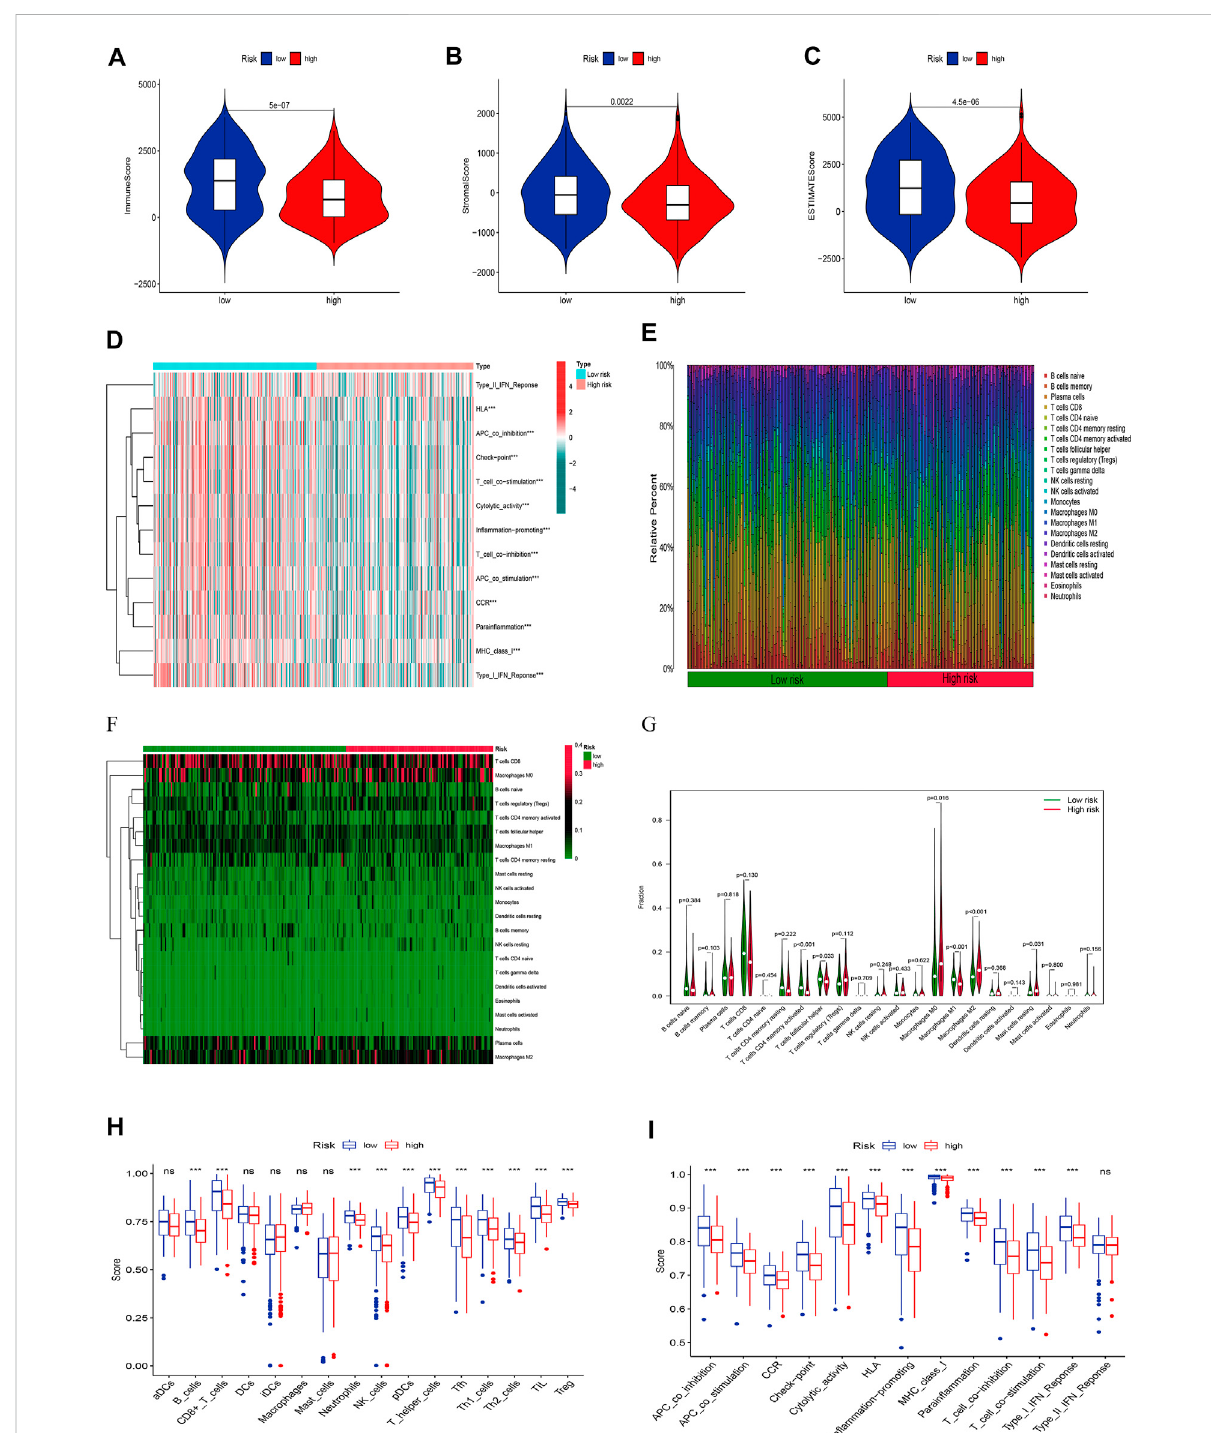
FIGURE 8 Analyses of tumor immune microenvironments between two groups. The differences of the immune score (A) , stromal score (B) , and estimate score (C) . (D) The GSVA of immune-related pathways between two groups. Expression features of 22 immune cells in the box plot (E) , heatmap (F) , and violin plot (G) using the CIBERSORT algorithm. The differences of the immune cells (H) , and immune functions (I) using the ssGSEA